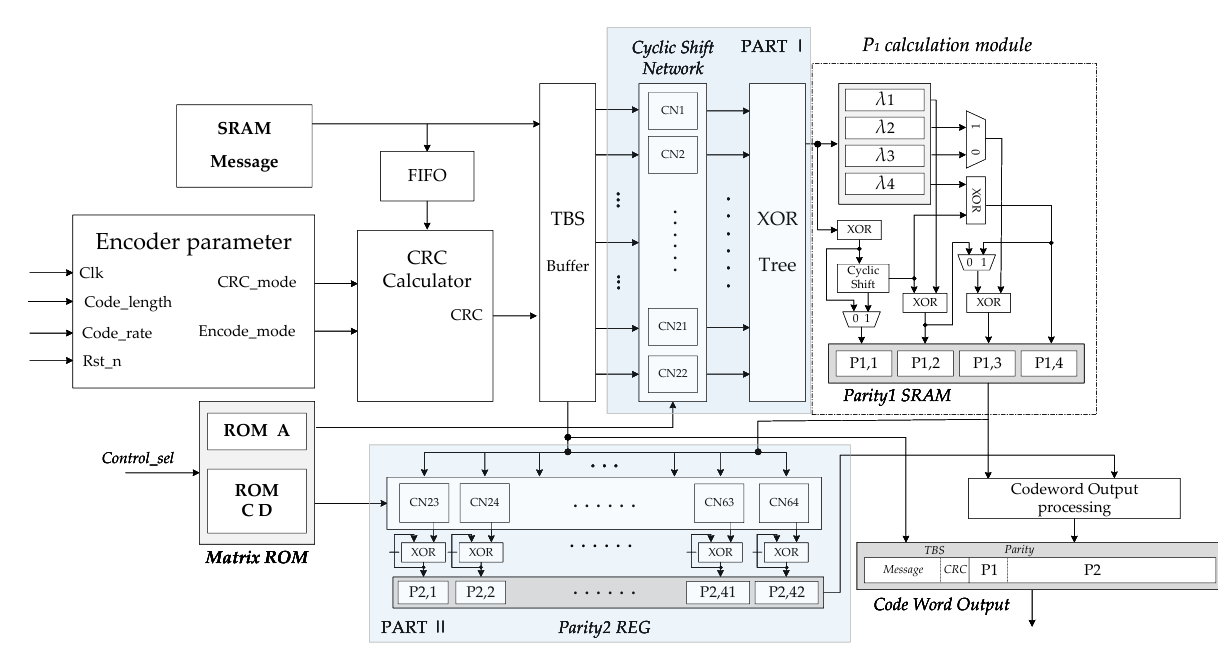
Figure 5. Low latency encoder architecture of 5G QC-LDPC